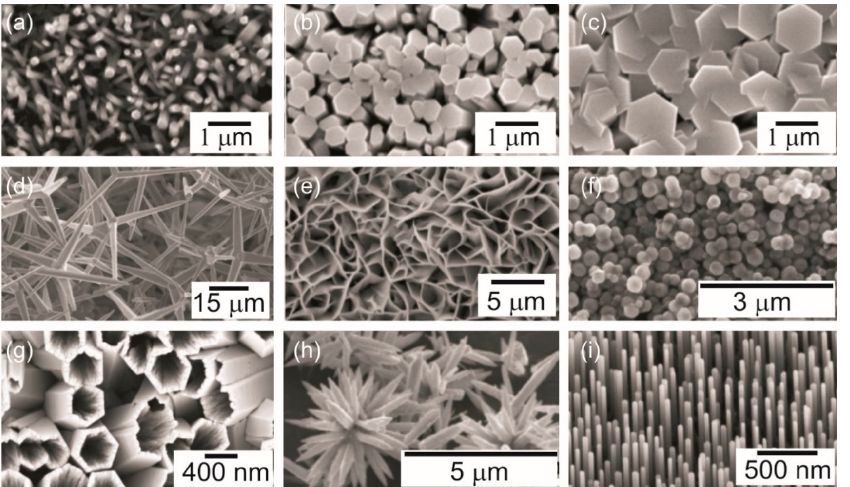
Figure 11. SEM images of several ZnO nanostructures. ( a ) ZnO nanorods [204] , ( b , c ) ZnO nanoplates [204] , ( d ) ZnO tetrapods [222] , ( e ) ZnO nanosheets [205] , ( f ) ZnO nanospheres [206] , ( g ) ZnO nanotubes [207] , ( h ) ZnO nanoflowers nanoplates [204], ( d ) ZnO tetrapods [222], ( e ) ZnO nanosheets [205], ( f ) ZnO nanospheres [209] , and ( i ) aligned ZnO nanowire arrays [208] . Reprinted with permission from direct growth of freestanding ZnO tetrapod networks for multifunctional applications in photocatalysis, UV photodetection, and gas sensing, ACS Appl.